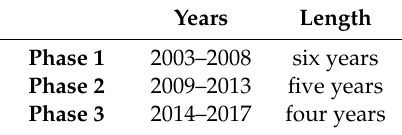
Table 2. Three phases divided through the sequential clustering method.